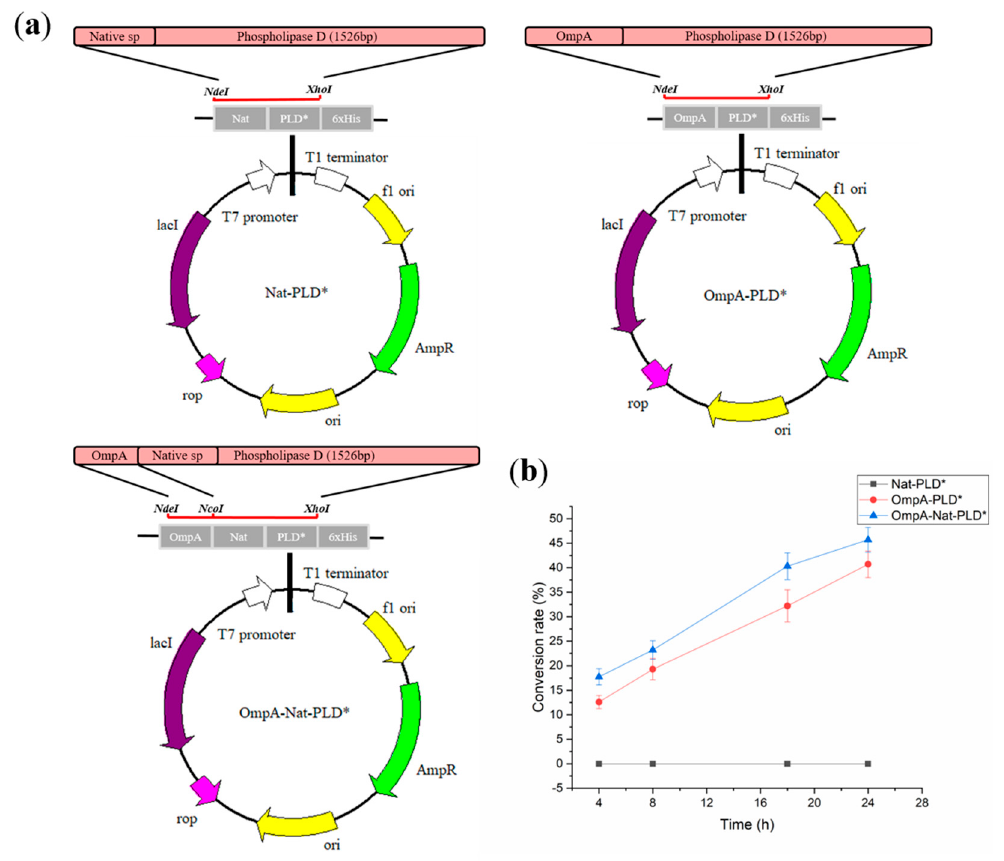
Figure 2. E ff ects of the Nat signal peptide on the transphosphatidyltion activity of recombinant PLD PMF expressed by E. coli . ( a ) Structure of the plasmids Nat-PLD *, OmpA-PLD * and OmpA-Nat-PLD *. ( b ) The conversion rates of phosphatidylcholine (PC) to phosphatidylserine (PS) catalyzed by the extracellular PLD expressed by the strain: BL21(DE3) / Nat-PLD *, BL21(DE3) / OmpA-PLD * and BL21(DE3) / OmpA-Nat-PLD *.